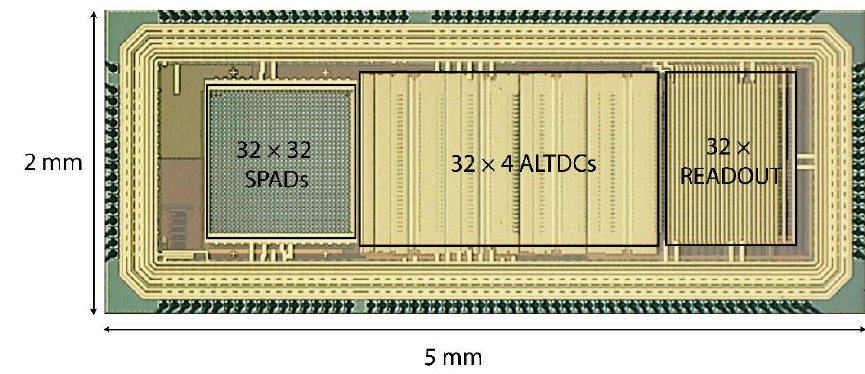
Figure 8. Chip microphotograph. Figure 8. Chip